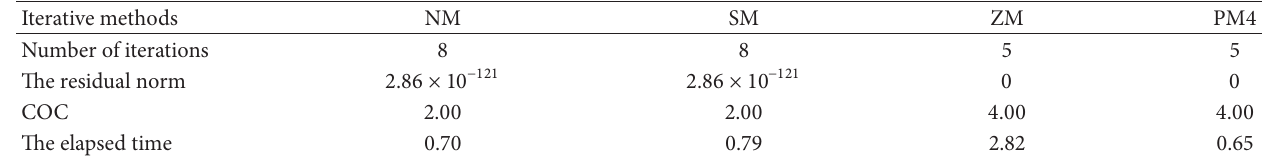
Table 2: Results of comparisons for different methods in Test 2 using x (0) = (2, ...,2) and 𝑁 = 99 . Iterative methods